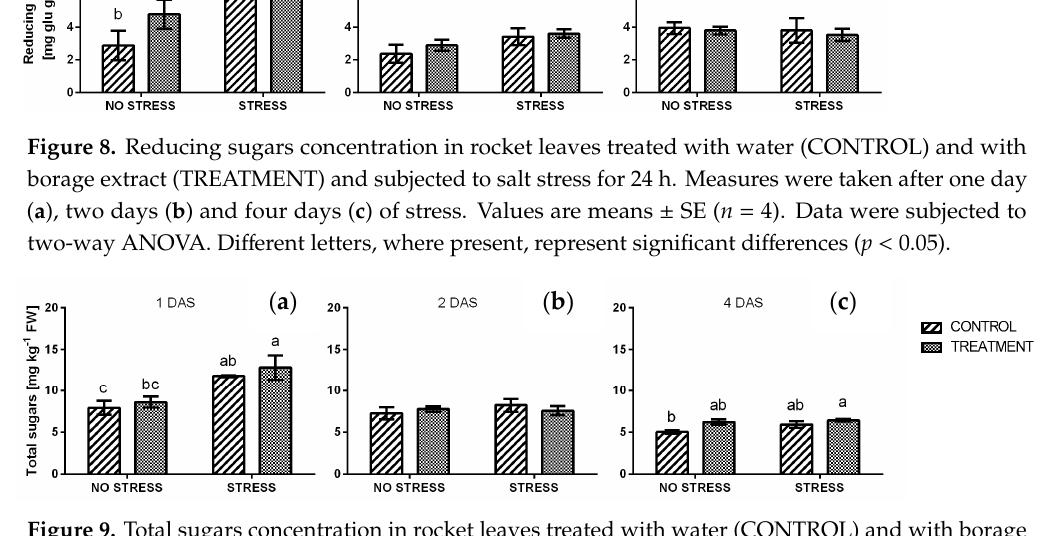
Figure 9. Total sugars concentration in rocket leaves treated with water (CONTROL) and with borage extract (TREATMENT) and subjected to salt stress (200 mM). Measures were taken after one day ( a ), two days ( b ) , and four days ( c ) of stress. Values are means ± SE ( n = 4). Data were subjected to two-way ANOVA. Different letters, where present, represent significant differences ( p < 0.05).